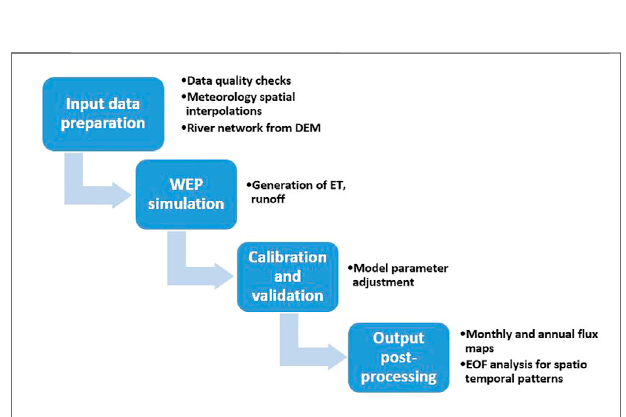
FIGURE 4 | Research methodology work fl